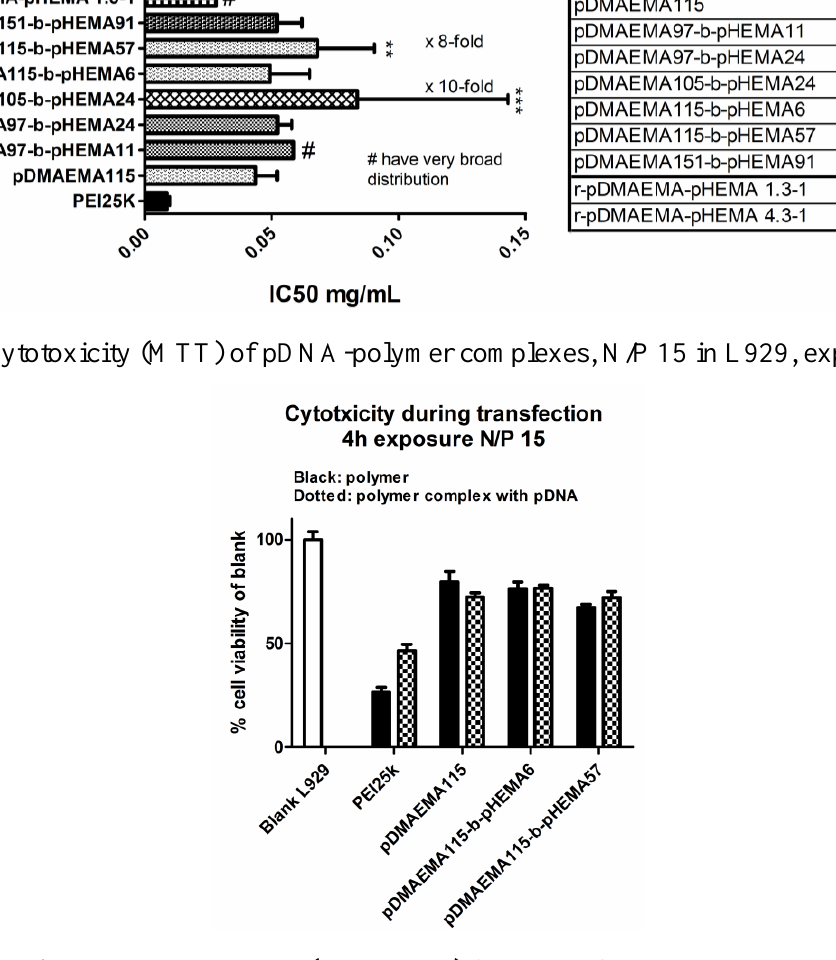
Figure 10. Protein data (BCA assay) from transfection